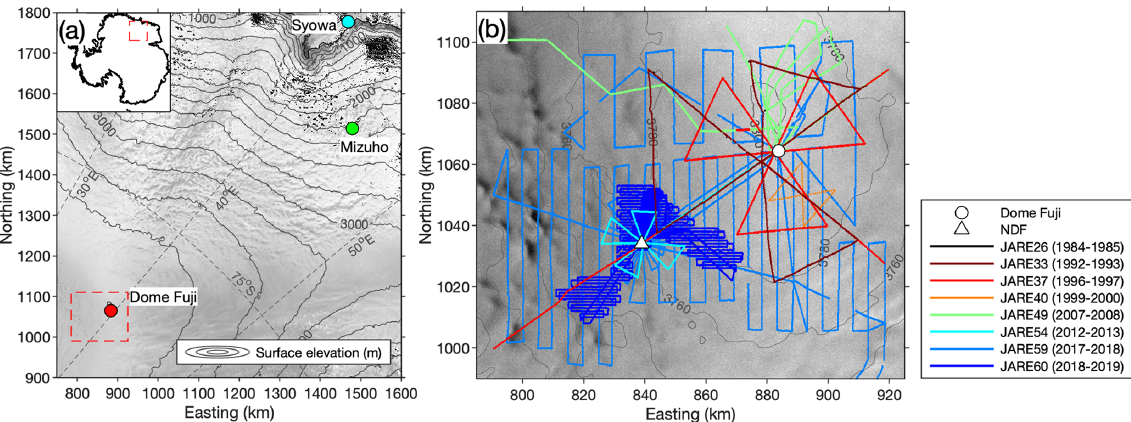
Figure 1. (a) An area of the traverse route between Syowa Station and Dome Fuji in Dronning Maud Land, East Antarctica, with a polar stereographic projection coordinate system. The box indicates the area shown in (b) . The inset shows the location of the region in Antarctica. The contours indicate surface elevation with intervals of 200m (Helm et al., 2014). (b) Dome Fuji region showing the coverage of the JARE radar survey lines. Surface elevation contours have intervals of 20m. The background is a RADARSAT-1 L1 image (© CSA,